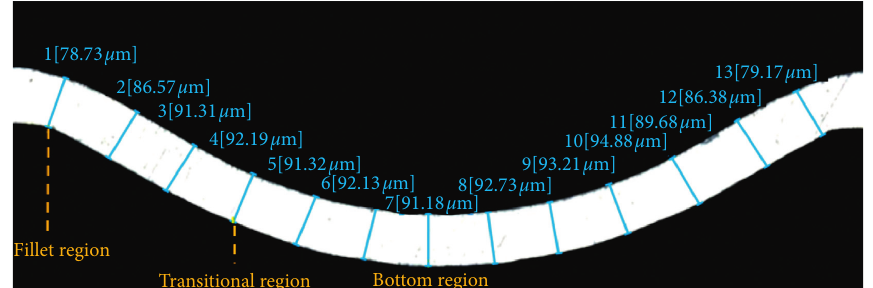
Figure 9: Thickness measurements of a material thickness of 100 μ m at 20MPa incident pressure.